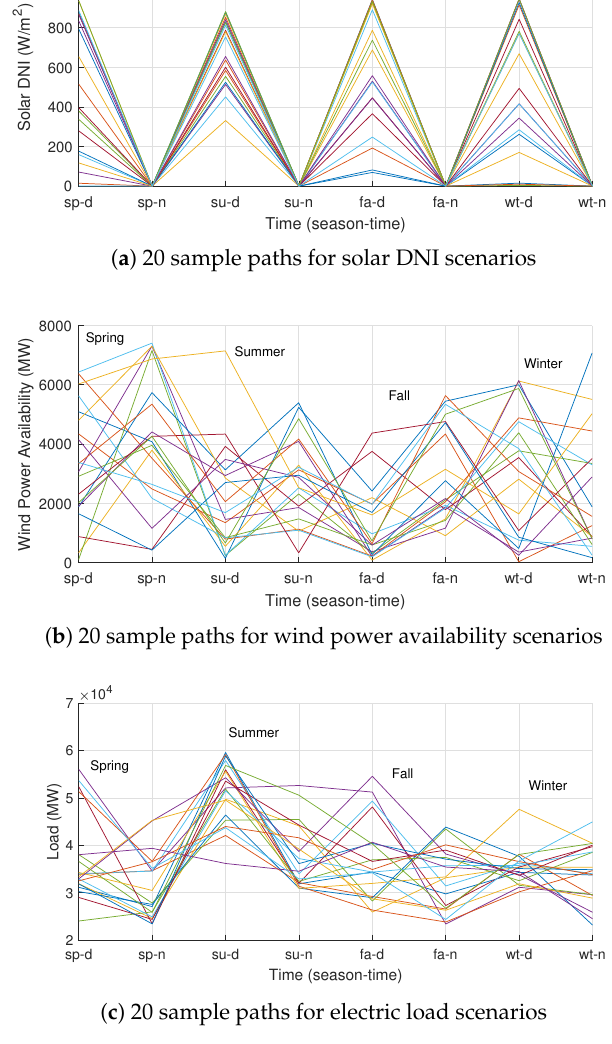
Figure 4. Random scenarios for four seasons, day and night times with gaussian